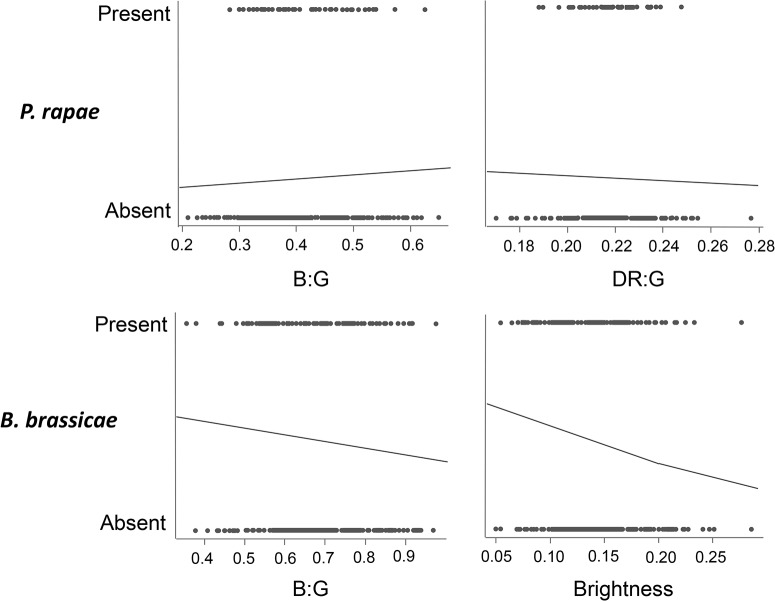
Relationship between B. oleracea leaf visual cues (B:G ratio, DR:G ratio and brightness) and the presence or absence of P. rapae and B. brassicae.Best fit lines were generated from GLMs with binomial errors with leaf colour as the predictor. P. rapae was more likely to be found on plants with higher B:G and lower DR:G, while B. brassicae was more likely to be found on plants with lower B:G and lower G (brightness).